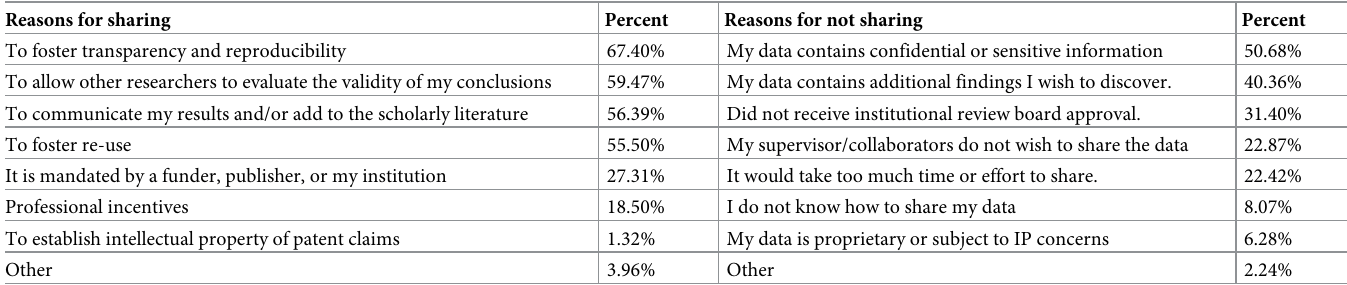
Table 4. Reasons for sharing and not sharing data. Despite the growth of data sharing mandates from scholarly publishers, funding bodies, and other stakeholders, par- ticipants more frequently responded that their sharing was motivated by broader reasons, such as a desire to foster reproducibility, transparency, validation, and re-use. “Other” motivations for sharing data included giving other investigators a chance to make discoveries, establishing an open science track record, and as a way to backup data. “Other” reasons for not sharing data included difficulty understanding how data sharing works in the context of tribal agreements and the cumbersome nature of sharing large